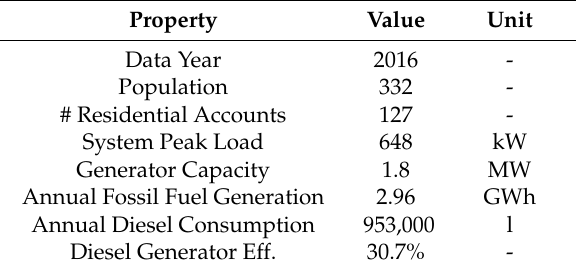
Table 1. Energy generation profile of the Kwadacha community [36].